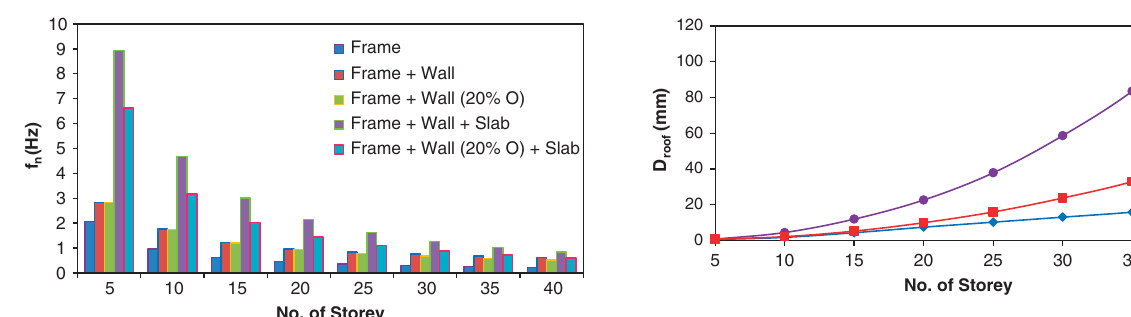
Fig. 6. Natural frequency, f n , considering wall openings